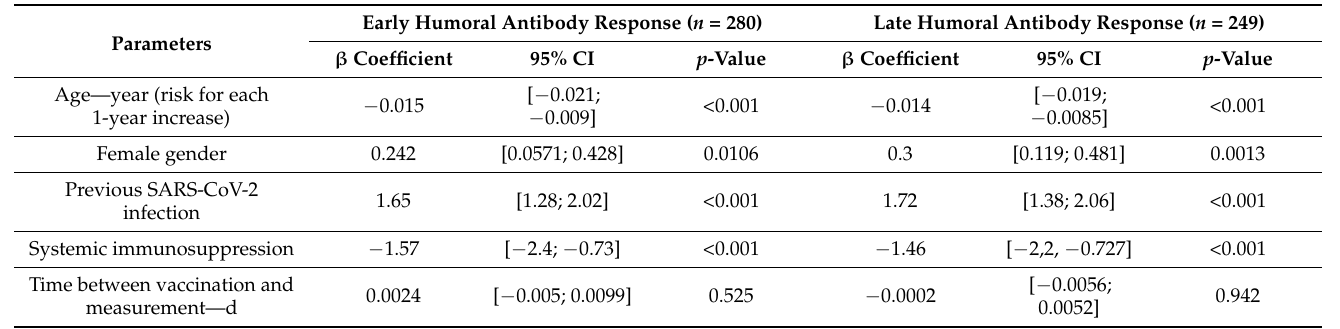
Table 2. Multivariate linear regression analyses of factors influencing the Anti-SARS-CoV-2 S antibody response to COVID-19 vaccination in hemodialysis